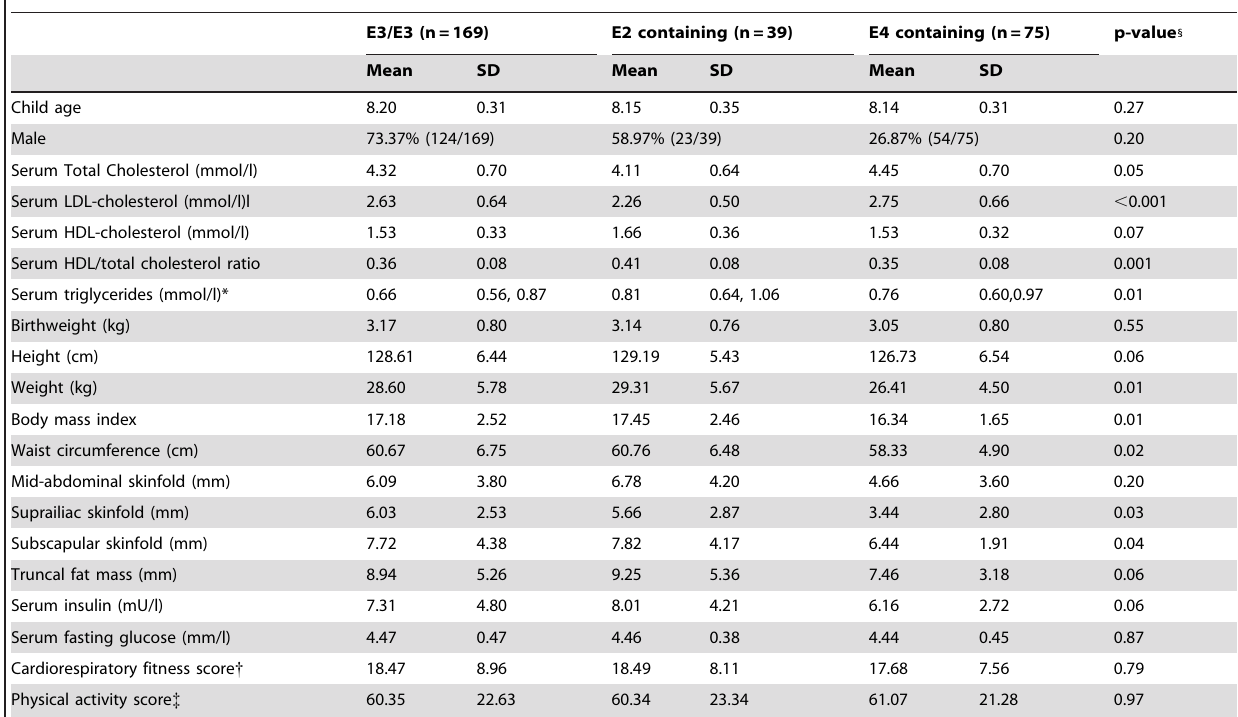
Table 1. Characteristics of the participants by ApoE genotype.